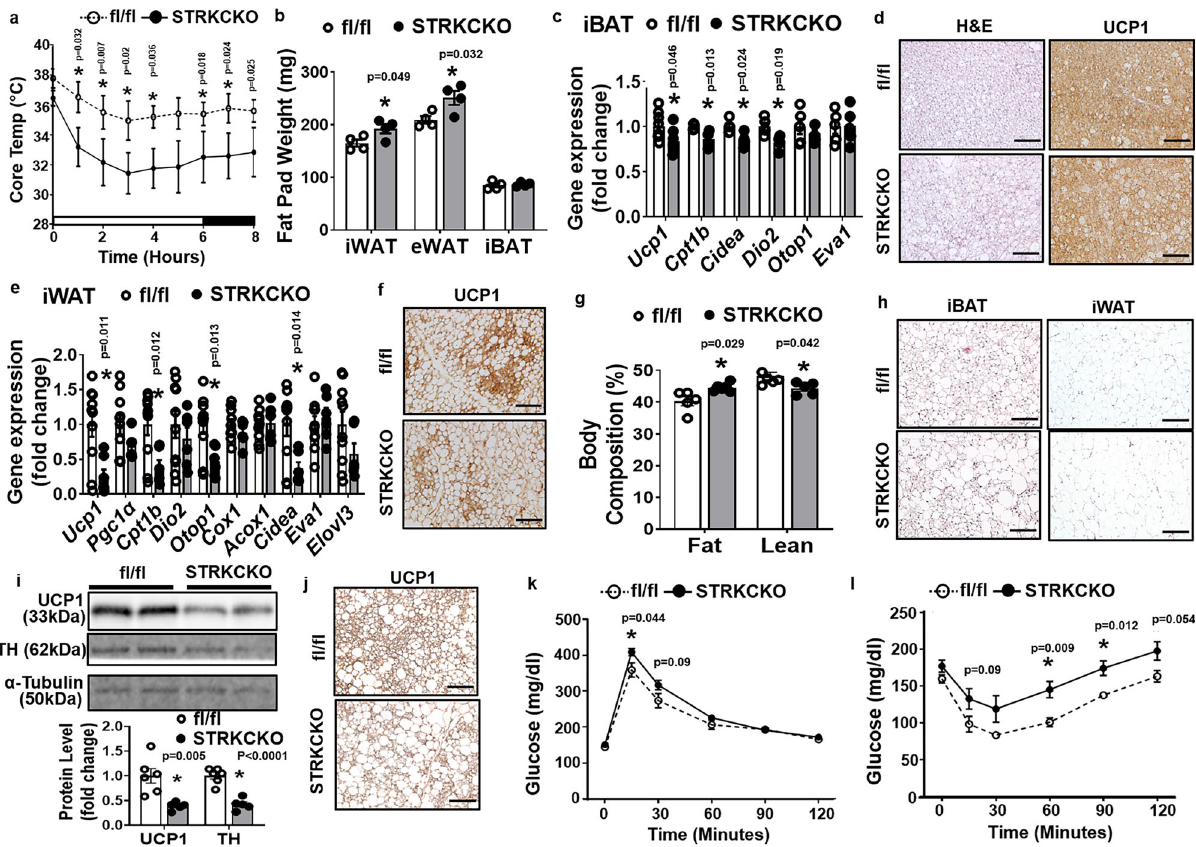
Fig. 9 Mice with speci fi c deletion of TRKC in sympathetic neurons exhibit impaired cold-induced thermogenesis and are prone to diet-induced obesity. a – f Core body temperature ( a , n = 4/group, * indicates statistical signi fi cance between fl / fl and STRKCKO with unpaired two-tailed t test), fat pad mass ( b , n = 4/group, * indicates statistical signi fi cance between fl / fl and STRKCKO with unpaired two-tailed t test), Ucp1 and other thermogenic gene expression in iBAT ( c , for Ucp1 , fl / fl n = 9, STRKCKO n = 7; for other genes, fl / fl n = 5, STRKCKO n = 4, * indicates statistical signi fi cance between fl / fl and STRKCKO with unpaired two-tailed t test), Representative H&E and UCP1 immunostaining in iBAT ( d , from three replicate animals/group, scale bar = 75 µ m), Ucp1 and other thermogenic gene expression in iWAT ( e , fl / fl n = 10, STRKCKO n = 6, * indicates statistical signi fi cance between fl / fl and STRKCKO with unpaired two-tailed t test), and representative UCP1 immunostaining images showing UCP1-positive beige adipocytes in iWAT ( f , from three replicate animals/group, scale bar = 150 µ m) of fl / fl and STRKCKO mice during a 7-day cold challenge. g – l Body composition ( g , n = 5/group, *indicates statistical signi fi cance between fl / fl and STRKCKO with unpaired two-tailed t test), representative H&E staining of iBAT and iWAT ( h , from three replicate animals/ group, scale bar for iBAT = 75 µ m, and for iWAT = 150 µ m), UCP1 and TH protein levels in iBAT ( i , fl / fl n = 6, STRKCKO n = 5, * indicates statistical signi fi cance between fl / fl and STRKCKO with unpaired two-tailed t test), representative UCP1 immunostaining in iBAT ( j , from three replicate animals/ group, scale bar = 75 µ m), GTT ( k , fl / fl n = 5, STRKCKO n = 6, * indicates statistical signi fi cance between fl / fl and STRKCKO with unpaired two-tailed t test) and ITT ( l , fl / fl n = 5, STRKCKO n = 6, * indicates statistical signi fi cance between fl / fl and STRKCKO with unpaired two-tailed t test) of fl / fl and STRKCKO mice fed a HFD. All data are expressed as mean ±